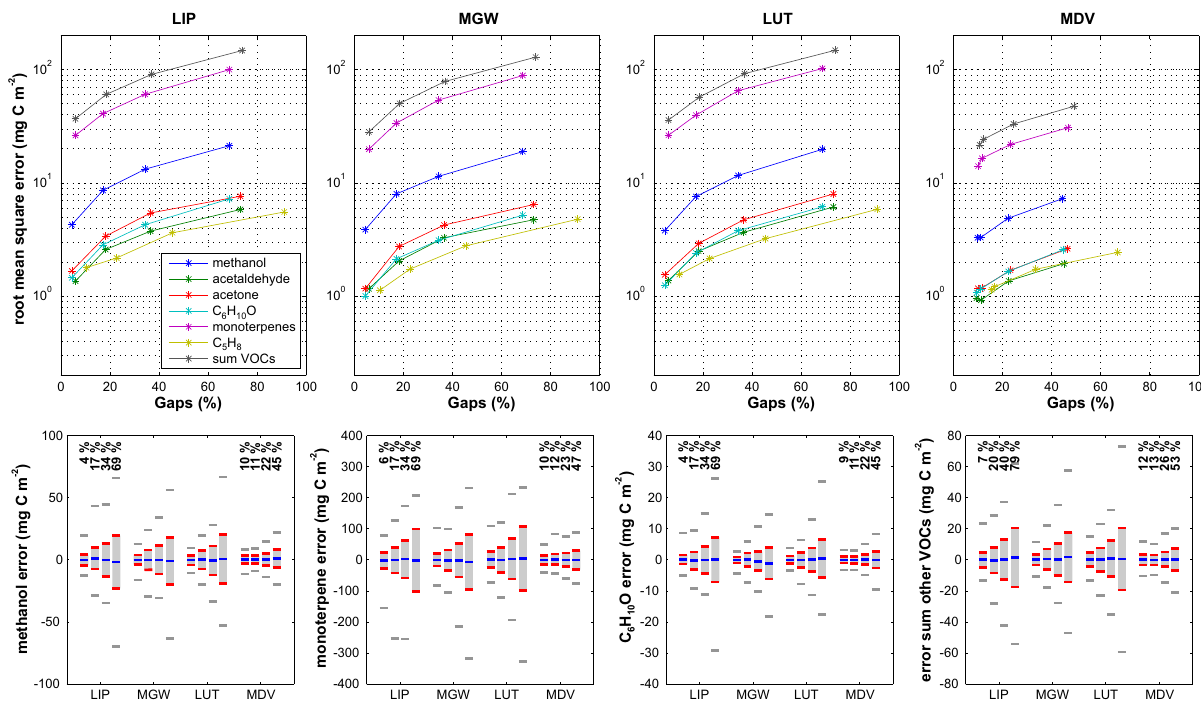
(%)MGW (%)LUT (%)MDV Gaps Gaps Gaps Fig. 3. Increase in root mean square errors introduced by gap-filling using the four different methods with an increasing number of gaps in the data series of quantified VOC fluxes (upper panels). Complete error statistics including mean error (blue horizontal line), ranges of root mean square errors (grey bars limited by red horizontal lines) and maximal (grey horizontal lines) errors for methanol ( m/z 33), monoterpenes ( m/z 137), C 6 H 10 O ( m/z 99) and the sum of other quantified VOCs (lower panels). All figures are exemplarily shown for the year 2009 only. The percentages in the lower panels refer to the total percentage of artificially introduced and filled data gaps used for the error